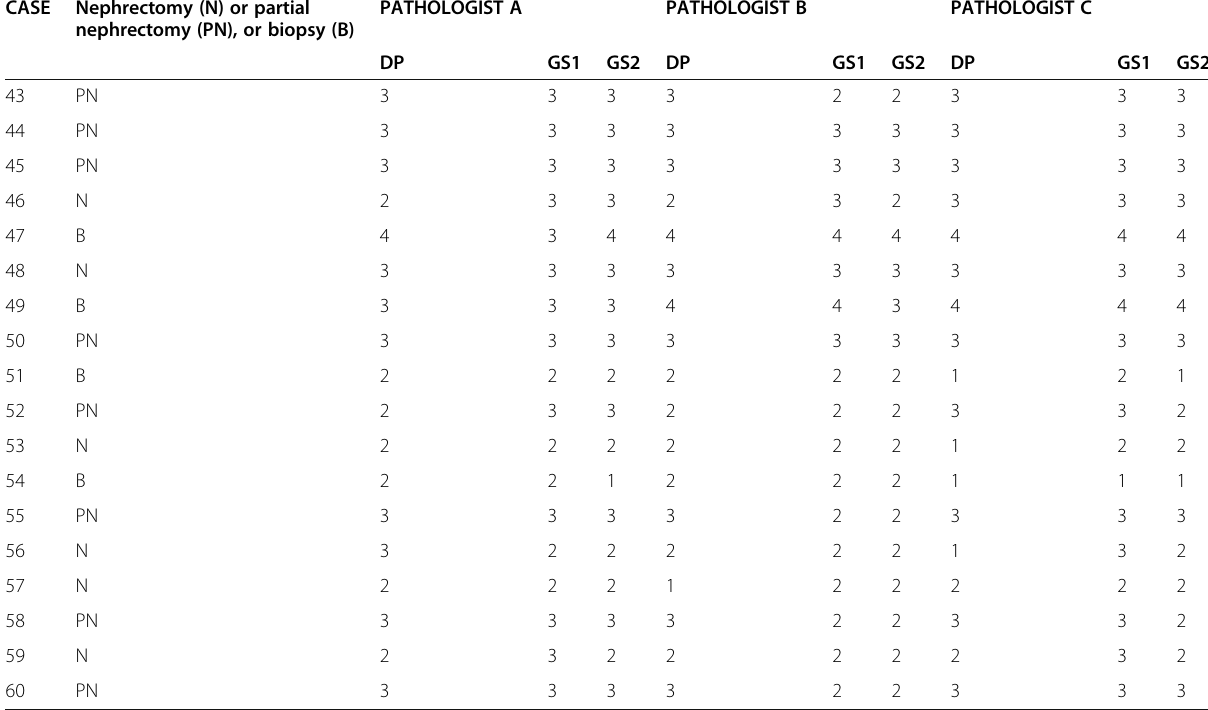
Table 1 Summary of all WHO/ISUP grading for all three pathologists on DP and on GS read 1 and GS read 2. Cases 1 – 50 = clear cell renal cell carcinoma. Case 51 – 60 = papillary renal cell carcinoma (Continued) CASE Nephrectomy (N) or partial nephrectomy (PN), or biopsy (B)